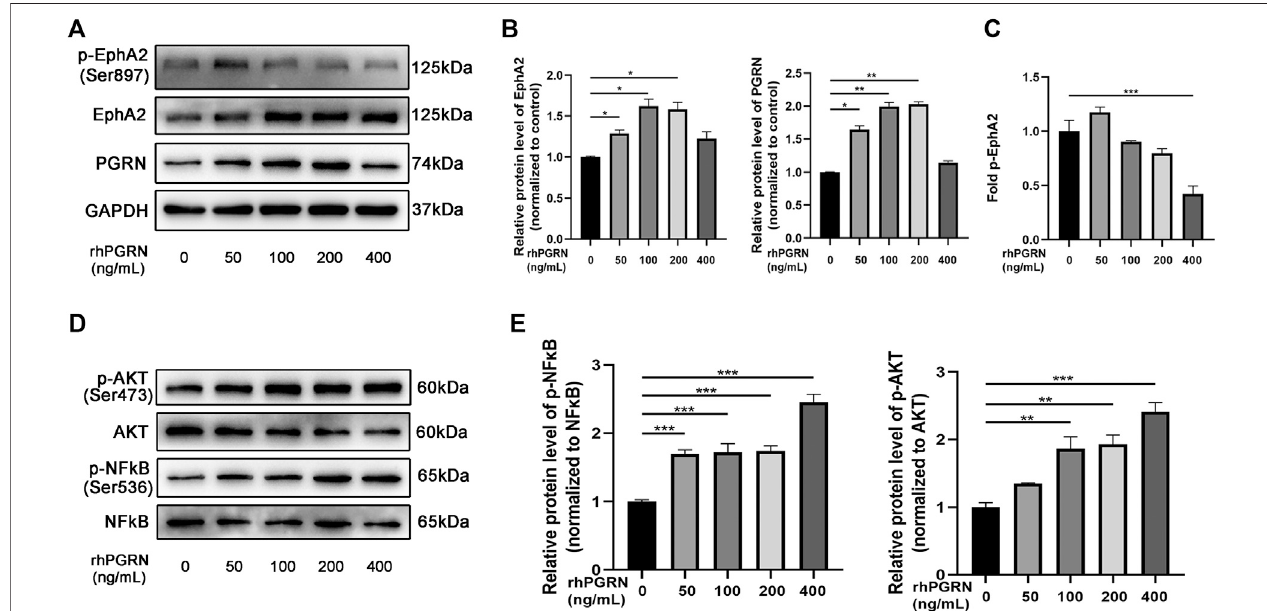
FIGURE 7 | The effect of exogenous rhPGRN on the PGRN/EphA2 axis and the NF- κ B p65 and AKT pathways. (A) HUVECs were administered with a variety of concentrations of rhPGRN (0, 50, 100, 200, 400 ng/mL) for 24 h. Western blotting gel documents of p-EphA2 (Ser897), EphA2, and PGRN showed relative protein levelsindifferentgroups. (B) The summarizeddataoftheprotein levels ofEphA2and PGRN (C) Thesummarized dataofthe protein levelsoffoldp-EphA2(Ser897). (D) Phospho-AKT(Ser473),totalAKT,NF- κ Bp65(Ser536),andtotalNF- κ Bp65signalingmoleculesweredetectedbytheWesternblotting. (E) Thesummarizeddata the levels phospho-NF- κ B p65 (Ser536), total NF- κ B p65. Data are presented as means ± SEM (* p < 0.05, ** p < 0.01, *** p < 0.001 vs. vehicle, ANOVA, n (cid:1) 3).